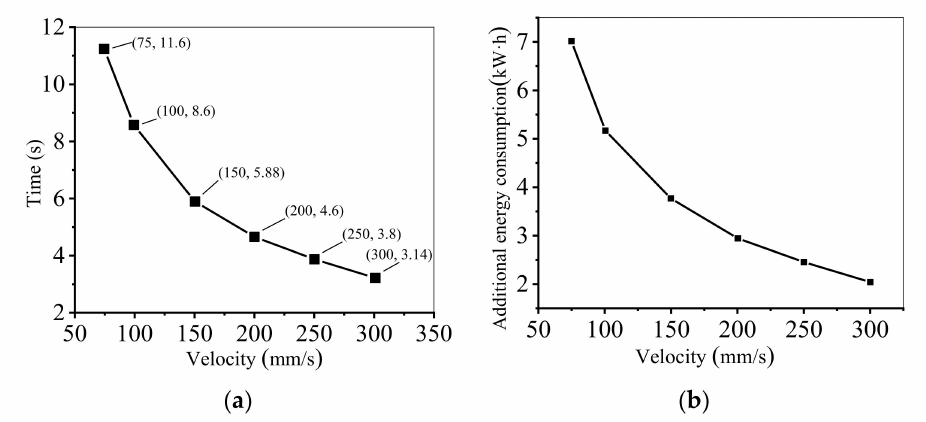
Figure 20. The variation of parameters with different brush cleaning speeds. ( a ) The influence time on the current field; ( b ) additional energy